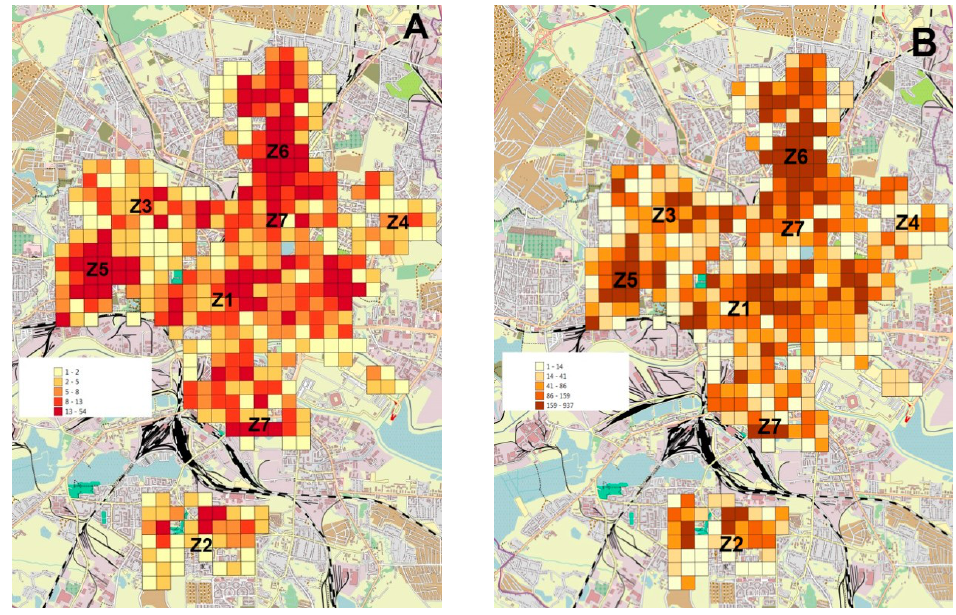
Figure 1. The map of mistletoe infestation occurrence in the city of Kaliningrad. ( A ) The frequency of occurrence of host trees attacked by V. album subsp. album in the research area. ( B ) The frequency of occurrence of V. album subsp. album in the research area. The labels Z1‒Z7 indicate the centers of research zones according to Table 3.